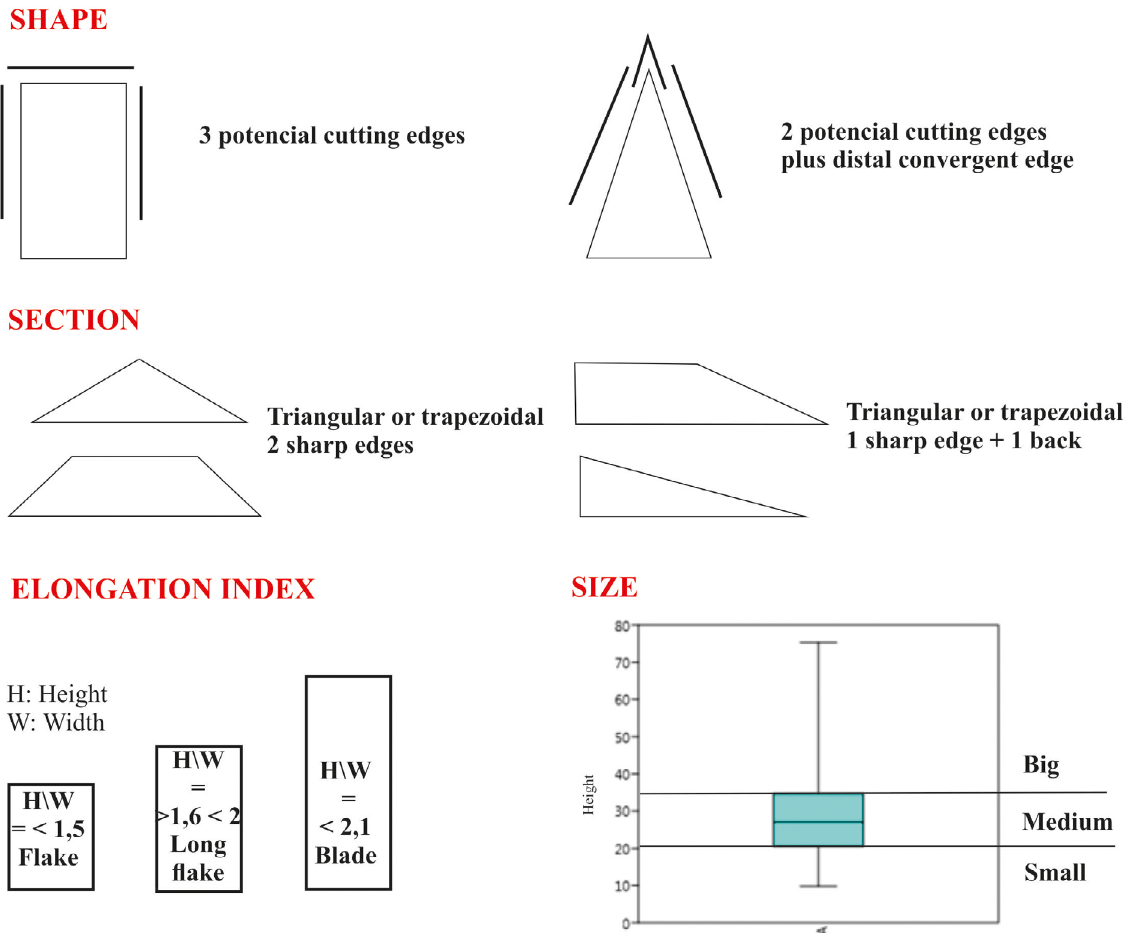
Figure 5. Shape, section, elongation index and size of the pieces (the size is based on the height of the pieces box plot realized with Past 3.16).